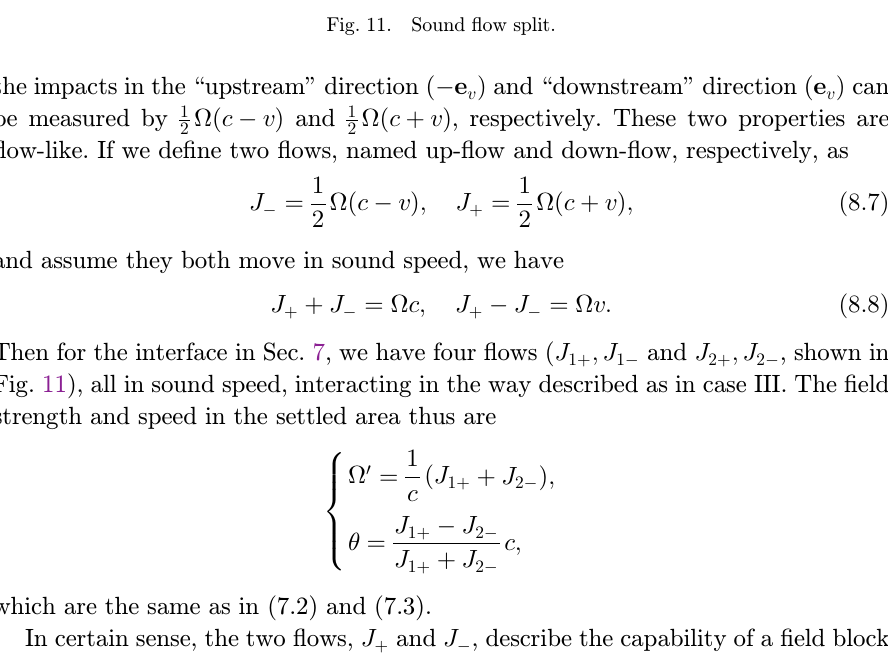
(b) Flow splitting at t ¼ (cid:3) . Fig. 11. Sound °ow